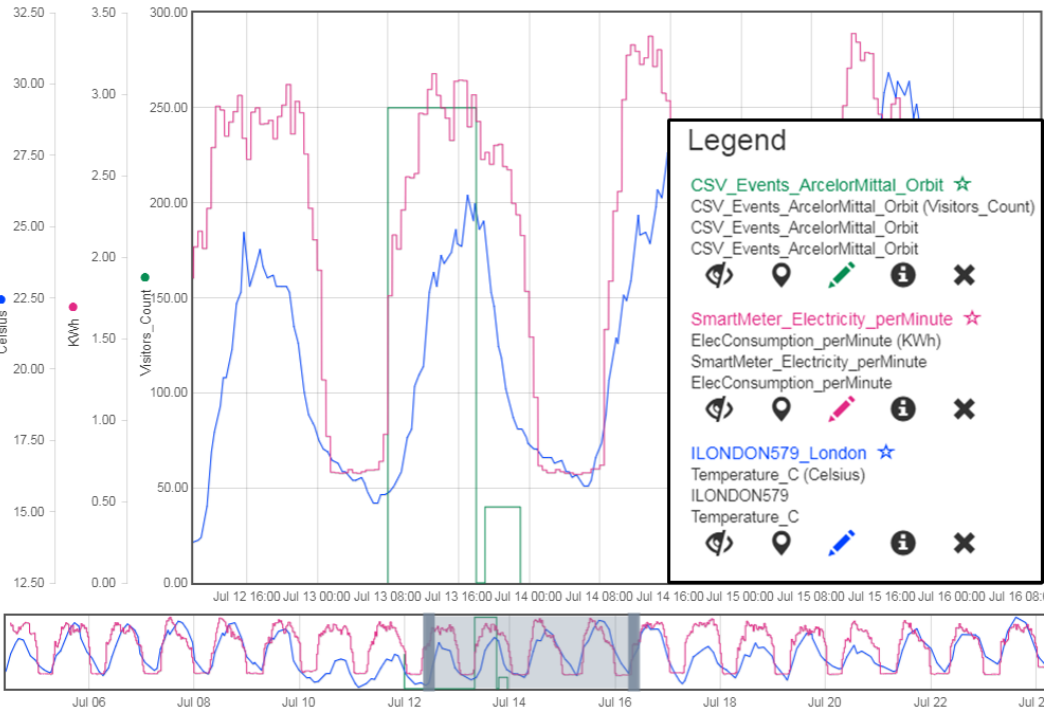
Figure 9. Joint visualizaion of observations being retrieved directly from heterogeneous data sources: (i) electricity consumption from a proprietary C3NTINEL platform in pink, (ii) Outside Temperature readings from the Weather Underground platform in blue, and (iii) scheduled event and visitor count from a CSV file in green. Screenshot taken from the Helgoland web client